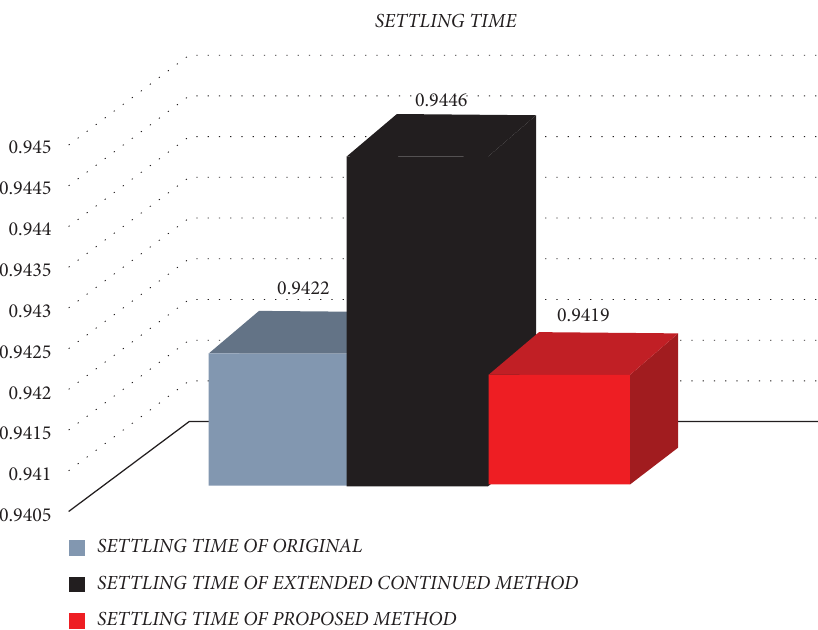
Figure 3: Comparison of settling time among the models (16)–(18).